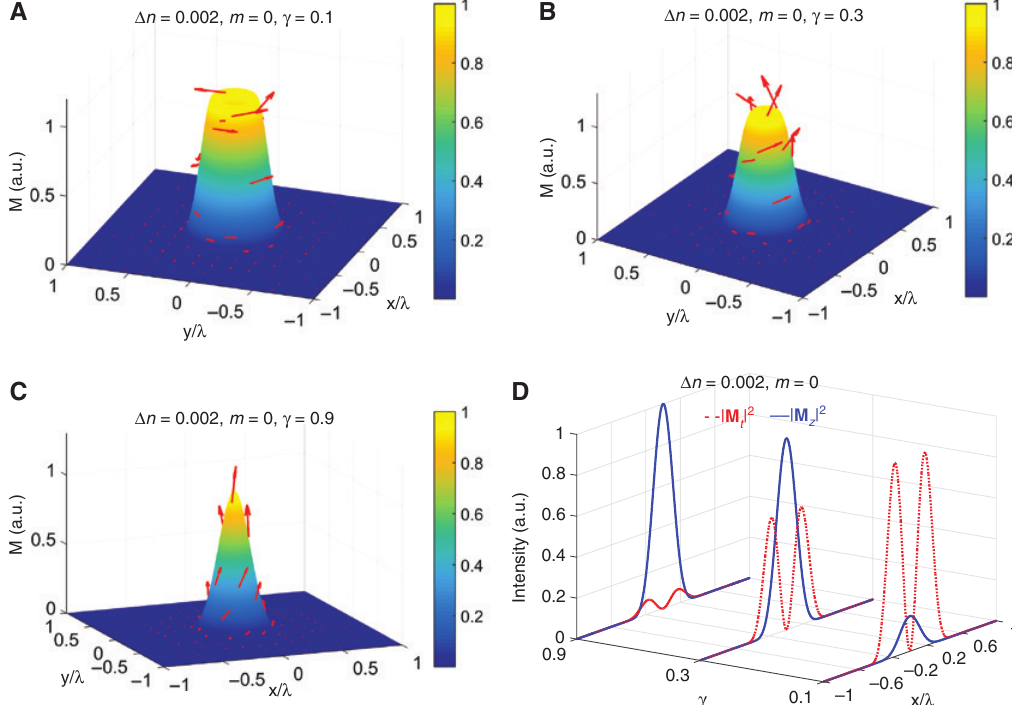
Figure 4: Magnetization pattern influenced by anisotropic optomagnetic response. (Color online) Anisotropic optomagnetic effect on the optically induced magnetization in a medium of Δ n = 0.002 and m = 0 with anisotropic optomagnetic response of (A) γ = 0.1, (B) γ = 0.3, and (C) γ = 0.9. (D) Cross-section of the transverse and longitudinal components for the cases of γ = 0.1, γ = 0.3, and γ =